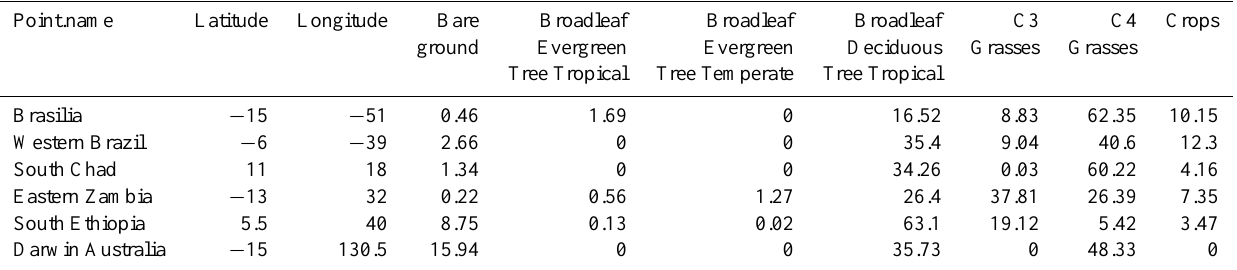
Table 1. List of locations for point simulations and percent cover of plant functional types (PFTs). PFTs with no coverage at any point are not